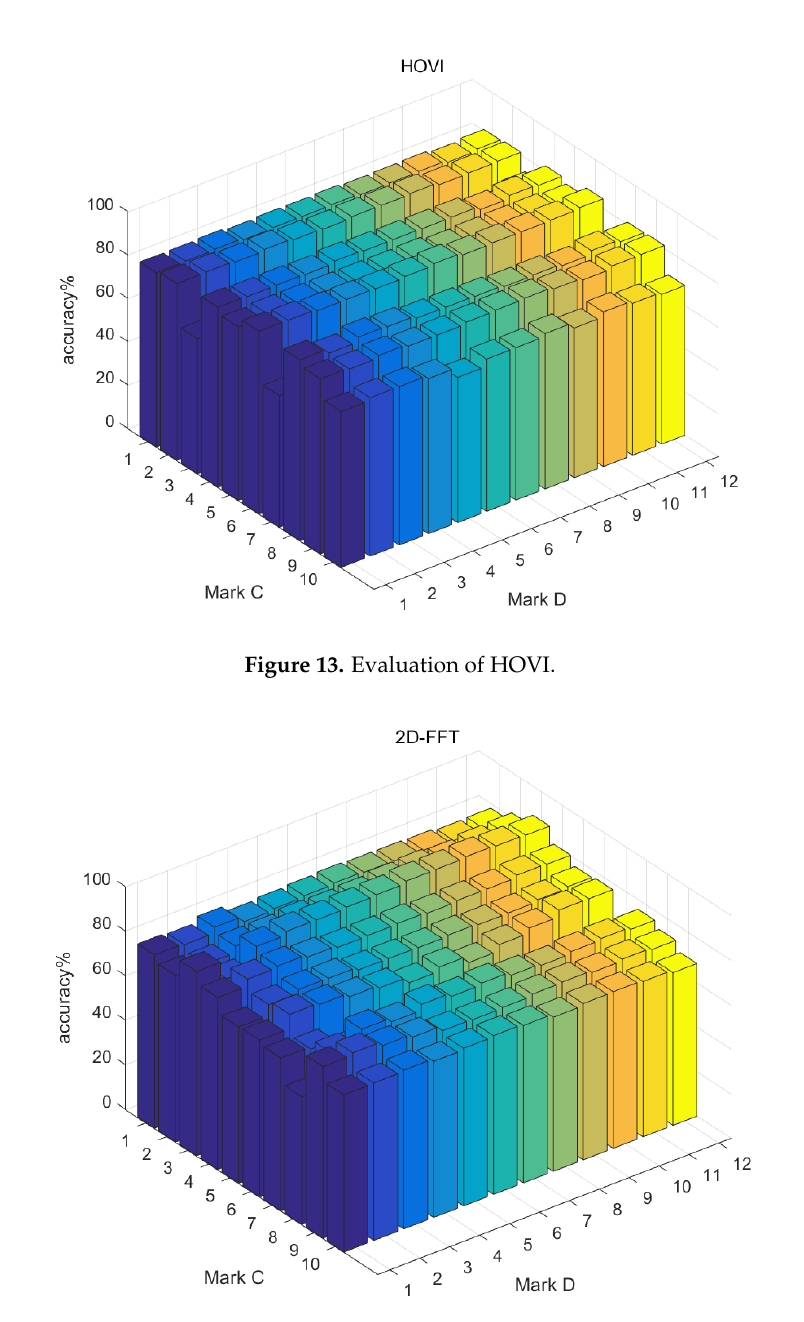
Figure 14. Evaluation of